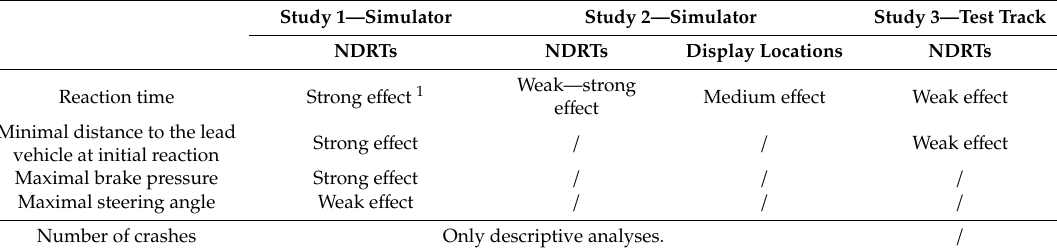
Table 5. E ff ects of the parameters used to examine take-over capabilities across the three studies.